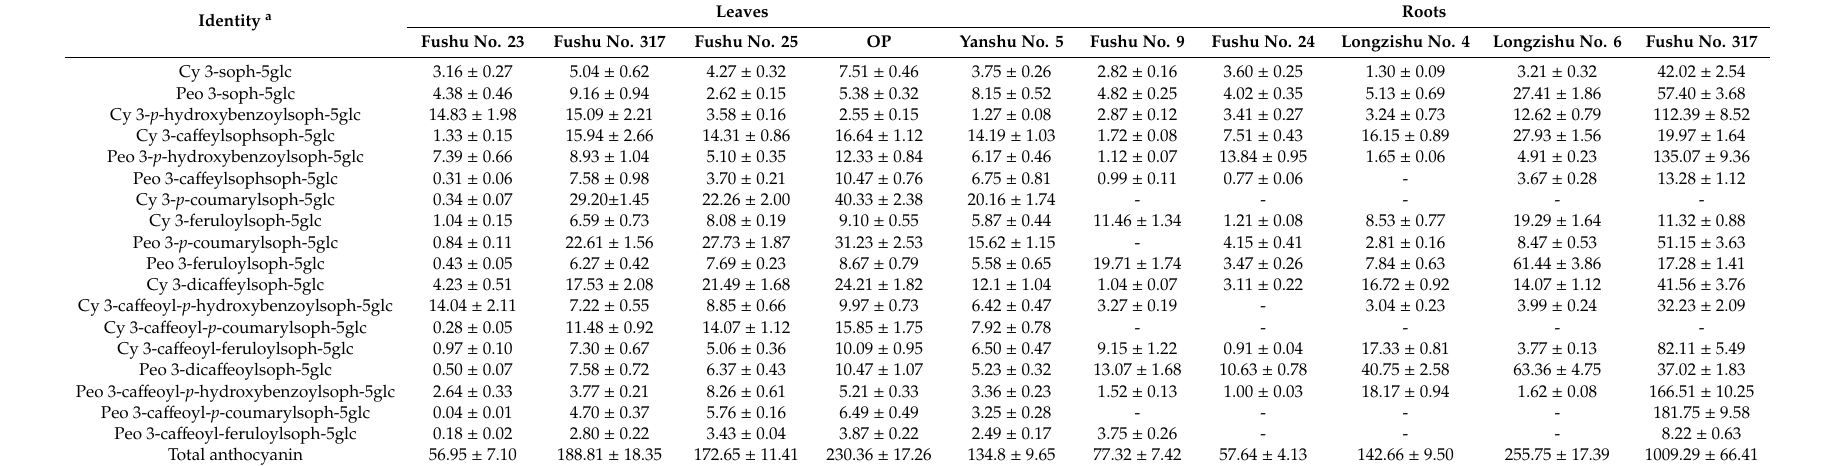
Table 3. Quantity of anthocyanins (1–14) from the leaves and roots of di ff erent sweet potato cultivars ( µ g / g FW). Identity